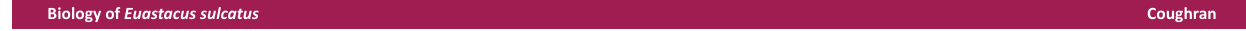
, time in months between capture m